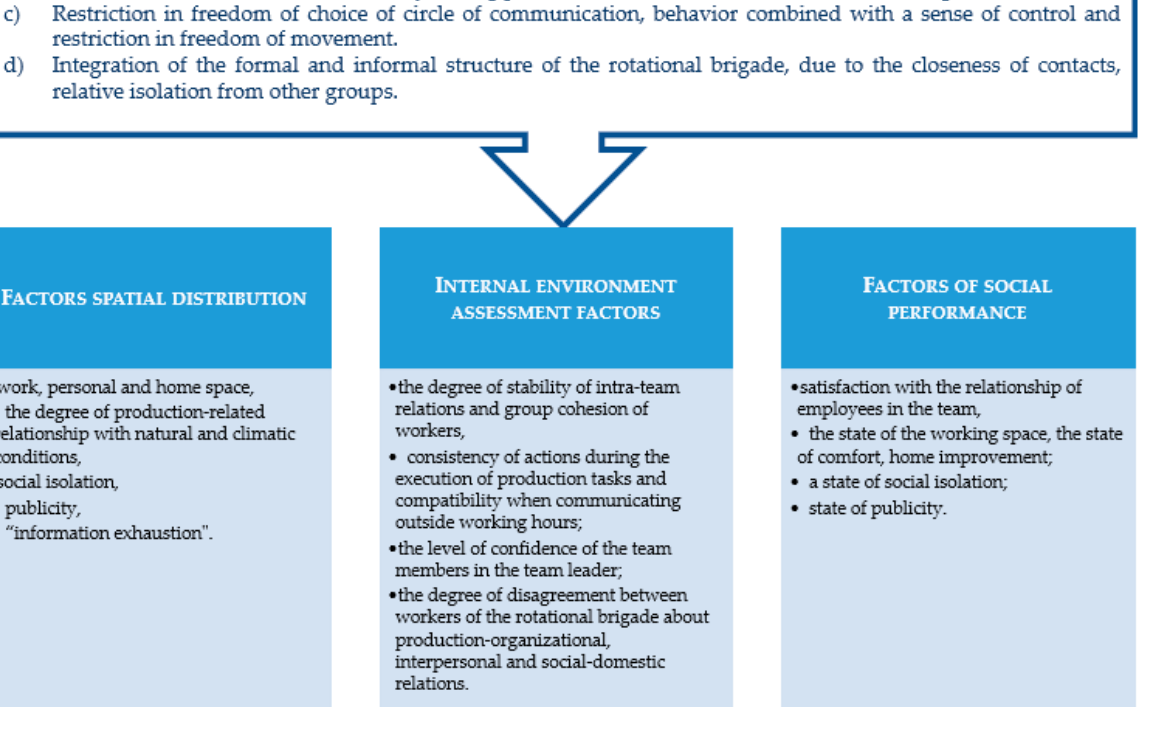
Figure 1. Features of social interaction in the FIFO team and the system of indicators of the parameters of its activities (based on Davydova’s results [63]).